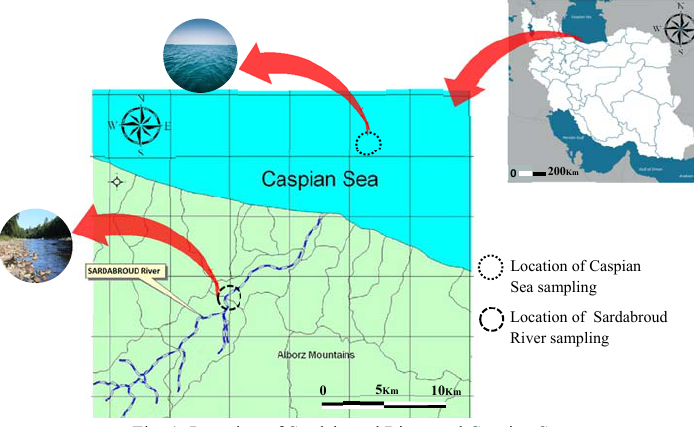
Fig. 1: Location of Sardabroud River and Caspian Sea Table 1: Mixture proportionality of saline and fresh water in 6 aquariums